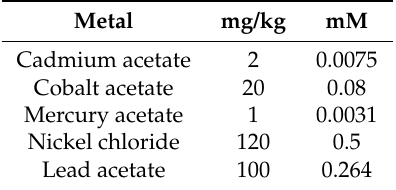
Table 1. Limits for heavy metal concentrations in green areas (Italian law D.lgs.